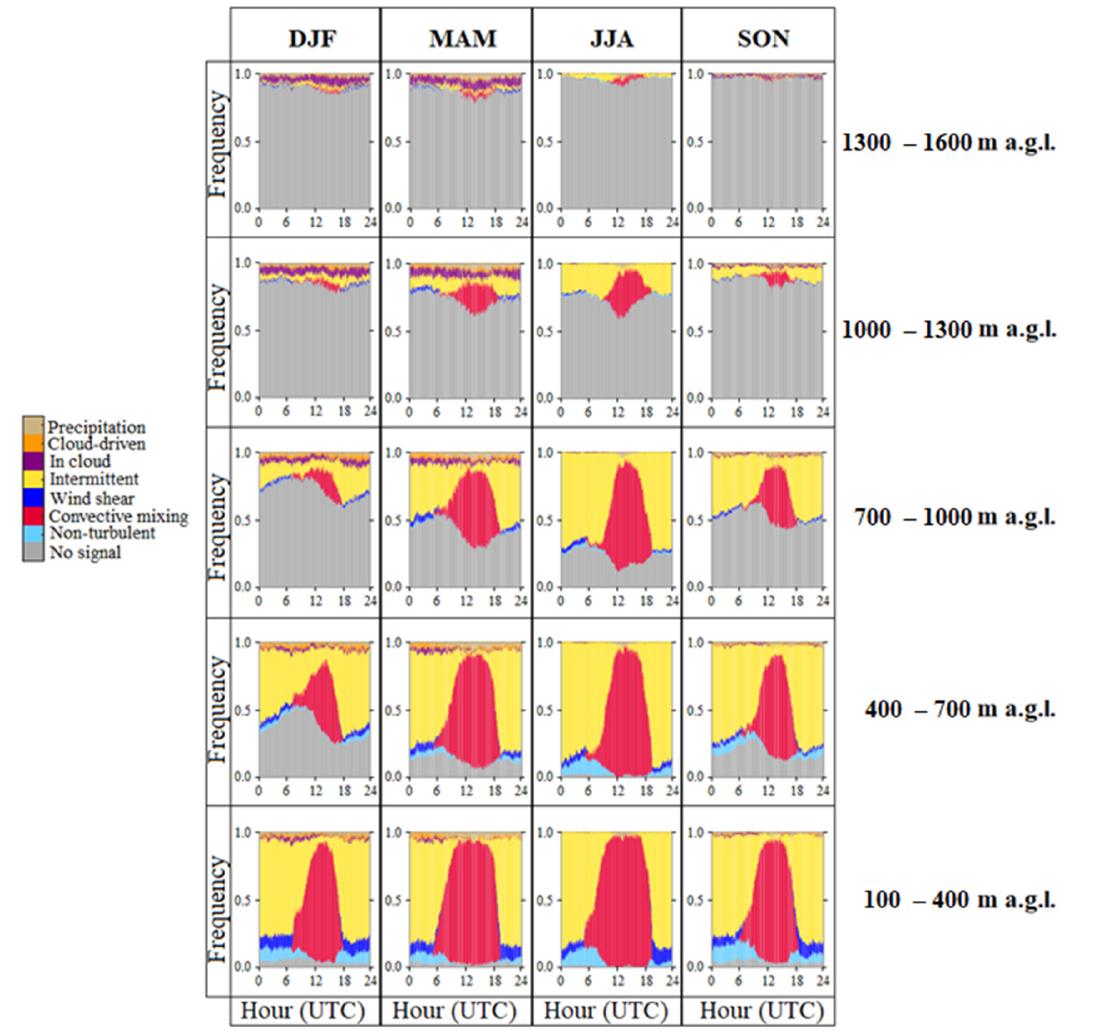
Figure 7. Diurnal cycle of the observed frequency of occurrence of each labelled turbulent source, for each season and calculated for five different height ranges at Granada station from 3 May 2016 to 2 May 2018.